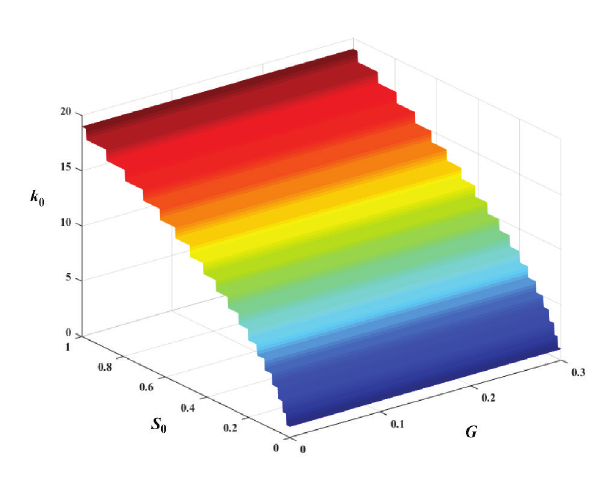
Figure 9. Relationship between k 0 , S 0 and G